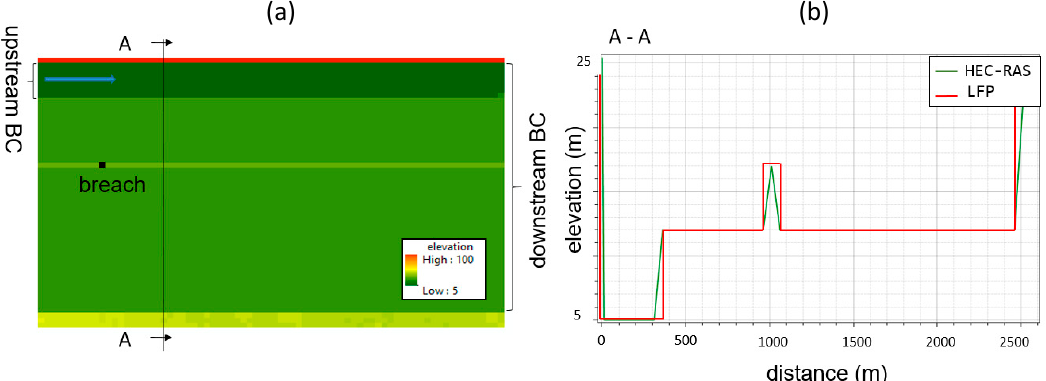
Figure 2. Synthetic DEM with boundary conditions (BC) used in both models ( a ); terrain cross-sections as reproduced by HEC-RAS and LISFLOOD-FP (LFP) from north to south ( b ).